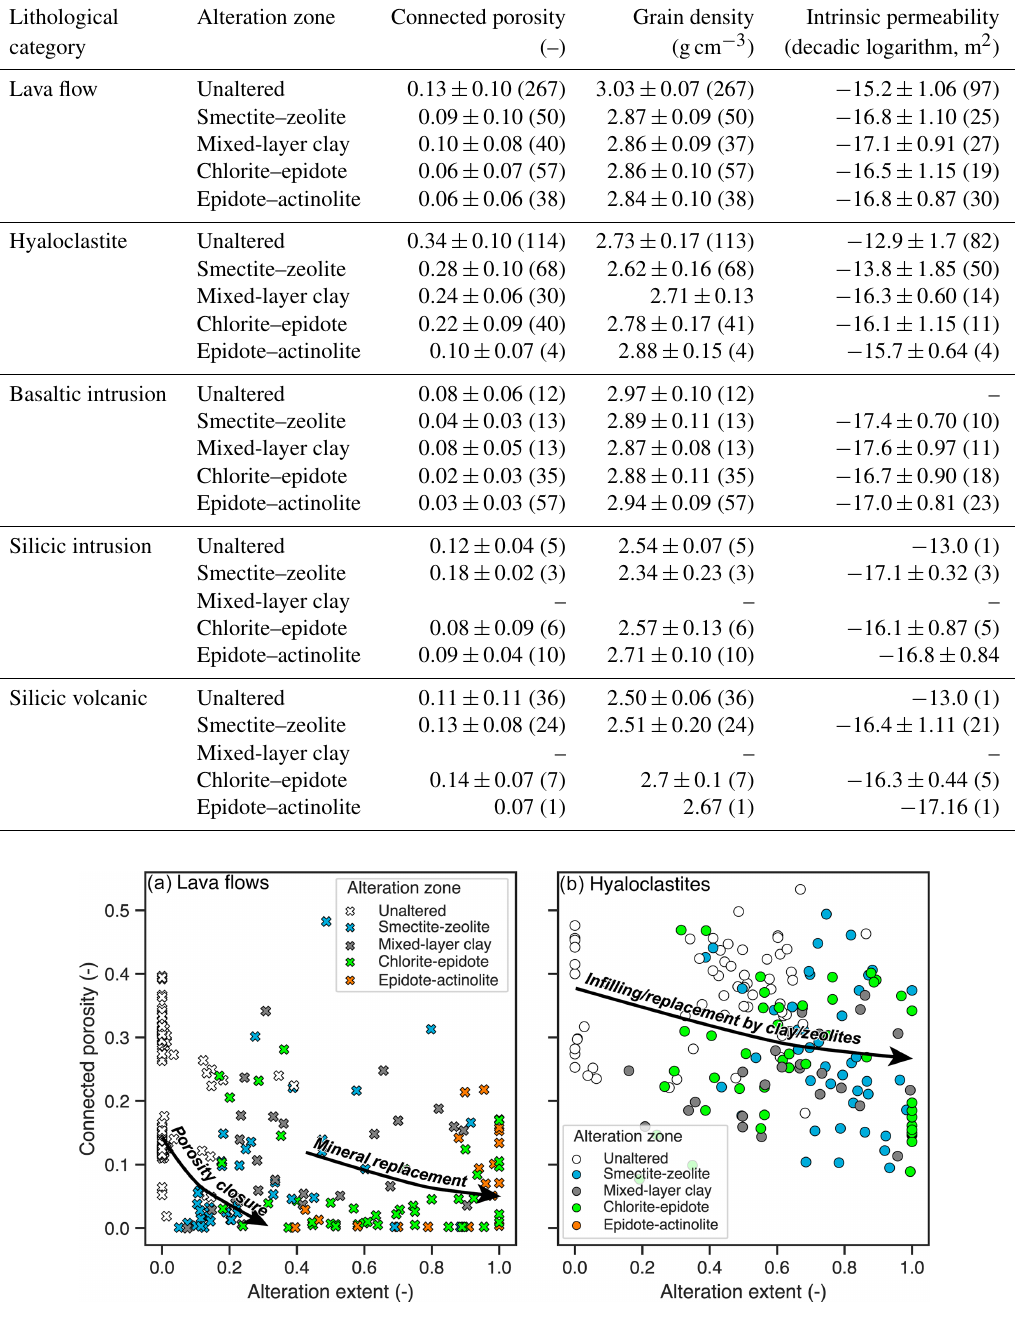
Table 5. Summary statistics for connected porosity, grain density, and intrinsic permeability for samples categorized by broad lithological identifier and alteration zone. The number of samples used to calculate the mean and standard deviation is presented in parentheses. Data are only presented for lithology–alteration zone combinations with sufficient data to calculate summary statistics. Note that the values given for intrinsic permeability were calculated using the decadic logarithm of the data.